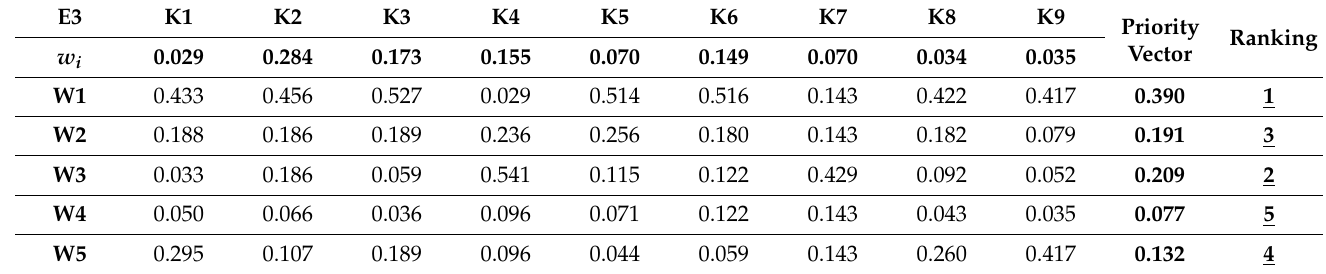
Table 5. Ranked list of the final weight distributions of the respective equipment variants according to Expert 3.